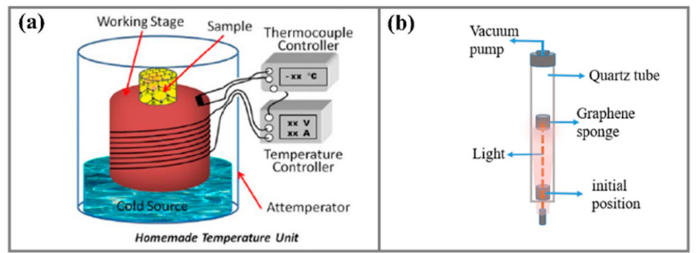
Figure 7. ( a ) Schematic of the preparation of bulk graphene sponge by hydrothermal method [77]. Permission from Springer Nature. ( b ) The schematic diagram of the vertical rise of graphene sponge under laser